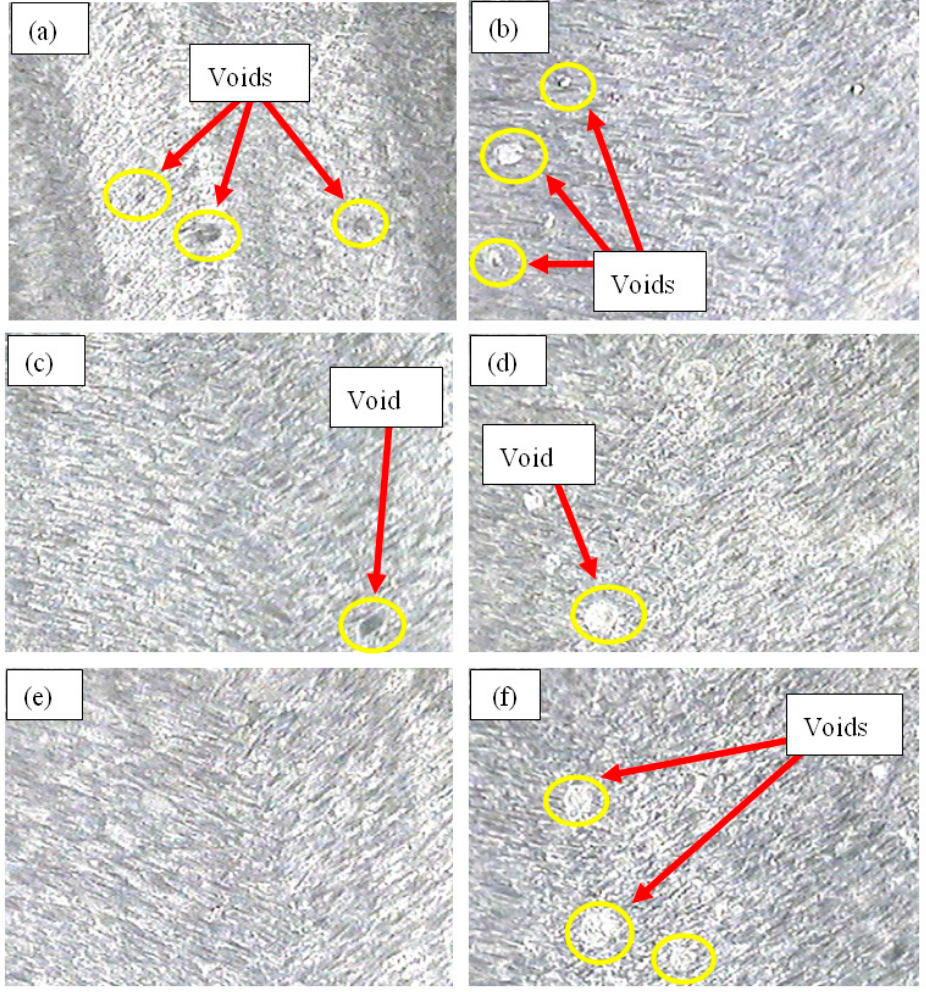
Figure 10. Surface profiles for different composites: ( a ) 0.5 wt.% AMWCNT–epoxy–kenaf, ( b ) 0.5 wt.% SMWCNT–epoxy–kenaf, ( c ) 0.75 wt.% AMWCNT–epoxy–kenaf ( d ) 0.75 wt.% SMWCNT– SMWCNT-epoxy-kenaf, ( c ) 0.75 wt.% AMWCNT-epoxy-kenaf ( d ) 0.75 wt.% SMWCNT-epoxy-kenaf epoxy–kenaf ( e ) 1 wt.% AMWCNT–epoxy–kenaf, and ( f ) 1 wt.% SMWCNT–epoxy–kenaf (magni- ( e ) 1 wt.% AMWCNT-epoxy-kenaf, and ( f ) 1 wt.% SMWCNT-epoxy-kenaf (magnification of 10 × fication of 10x).